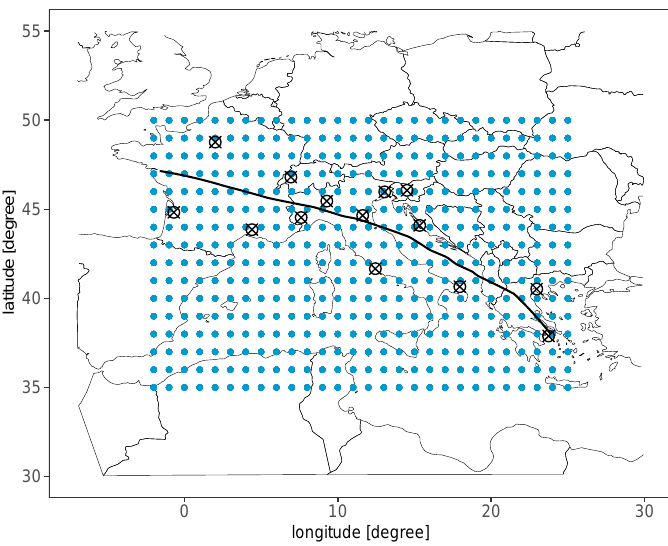
Figure A1. Blue points: the GFS data; black points: weather stations; black curve: the trajectory from Nantes to